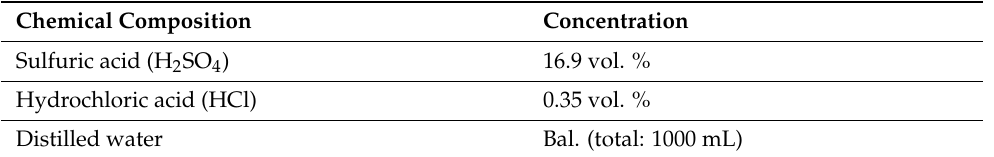
Table 2. Chemical composition of modified green death solution. Chemical Composition